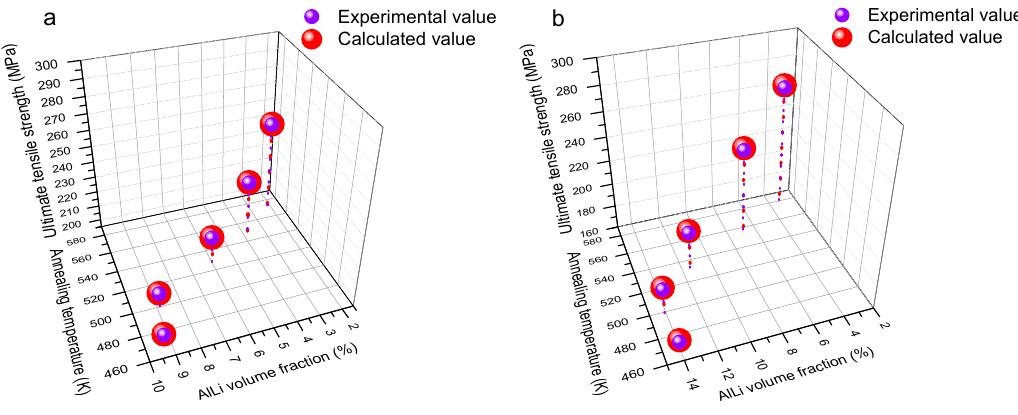
Figure 13. Fitting map of ultimate tensile strength under different volume fractions and temperatures: ( a ) Mg-8Li-3Al-2Zn-0.2Y; ( b ) Mg-11Li-3Al-2Zn-0.2Y.